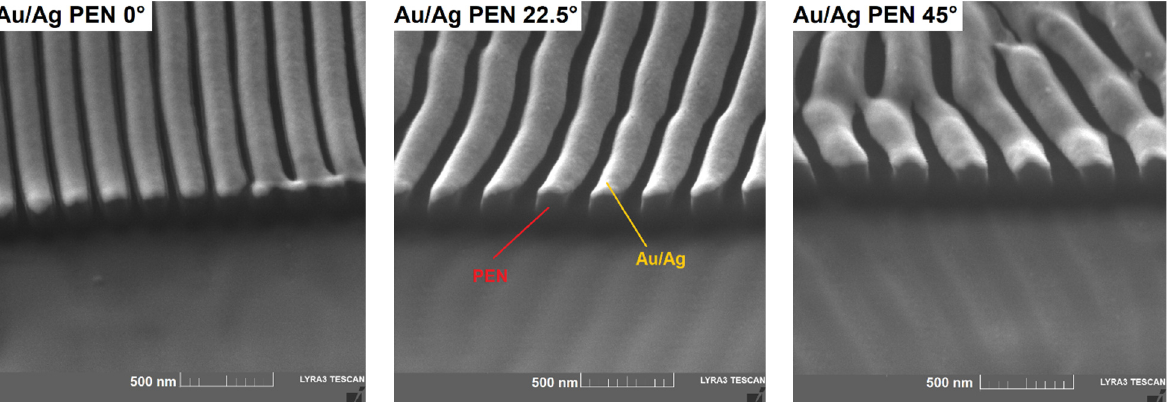
Figure 3. Micrographs from FIB-SEM showing metal–polymer interfaces on the surfaces of Au/Ag PEN (0/22.5/45°) sam- ples.